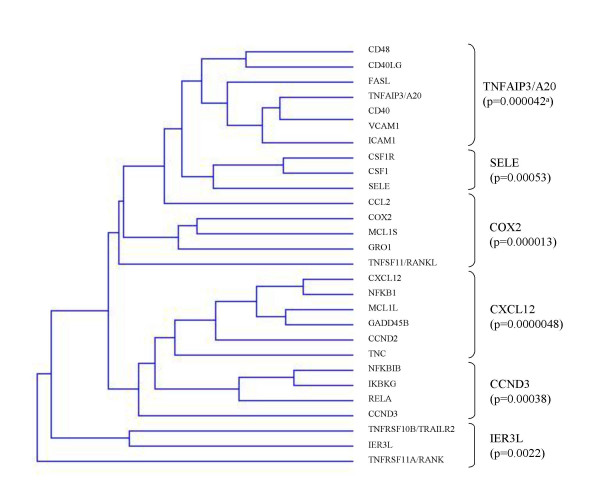
Dendrogram of the 28 most strongly upregulated genes (p < 0.01) constructed using hierarchical clustering, according to the gene profiling of the 57 IBCs and non IBCs. The 28 genes were categorized into 6 groups. The 6 most strongly upregulated genes (named master gene) within each group are indicated on the right (TNFAIP3/A20, SELE, COX2, CXCL12, CCND3, IER3L). a: Mann-Whitney U Test (see table 2).